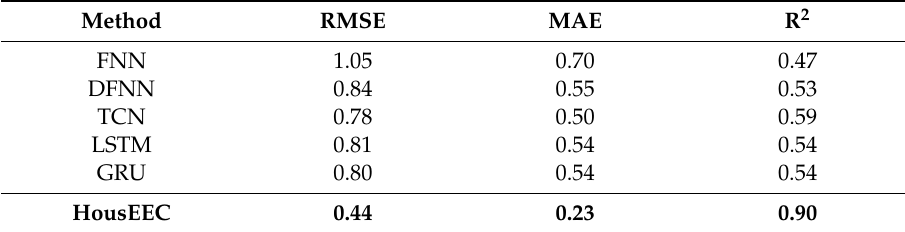
Table 4. Performance of end-to-end deep learning (DL) approaches.